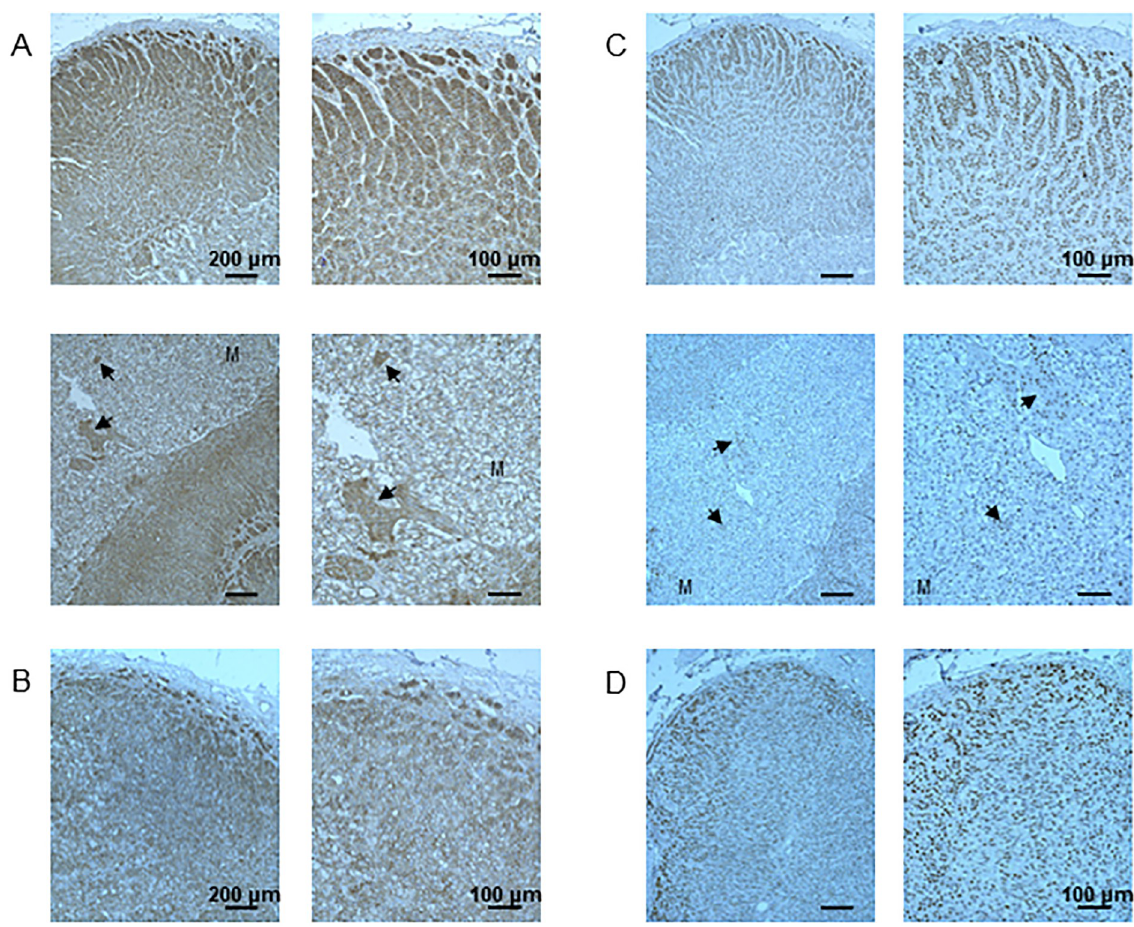
Fig 9. Wnt/ β -catenin pathway is activated in normal human adrenal gland. Immunostaining for β -catenin (A and B) allows detection of the protein throughout the cortex at the membrane and cytoplasmic/nucleus levels while β -catenin expression in chromaffin cells of the medulla (M) is restricted to the membrane (A, lower microphotographs). Lef-1 expression is detected in the nucleus of cortical cells (C and D) and not in chromaffin cells (C, lower microphotographs). (cid:2) indicates cluster of cortical cells expressing β -catenin (A) or Lef-1 (C) in the medulla and in the vicinity of the central vasculature of the adrenal gland. (A and C) 30-year-old man. (B and D) 70-year-old